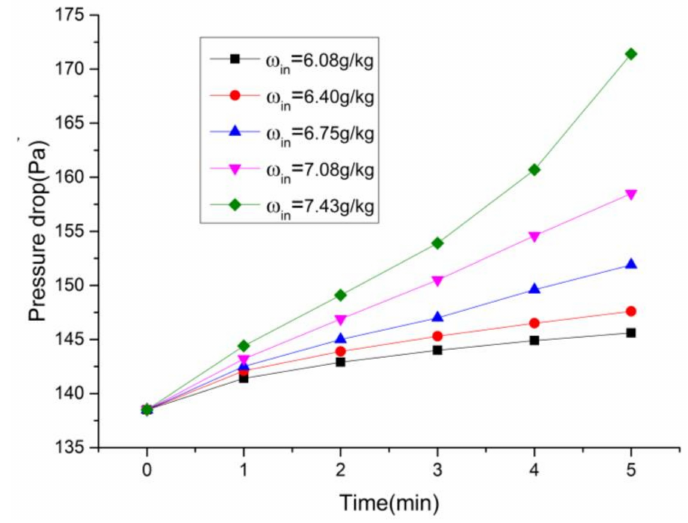
Figure 22. Variation of pressure drop with different ω in